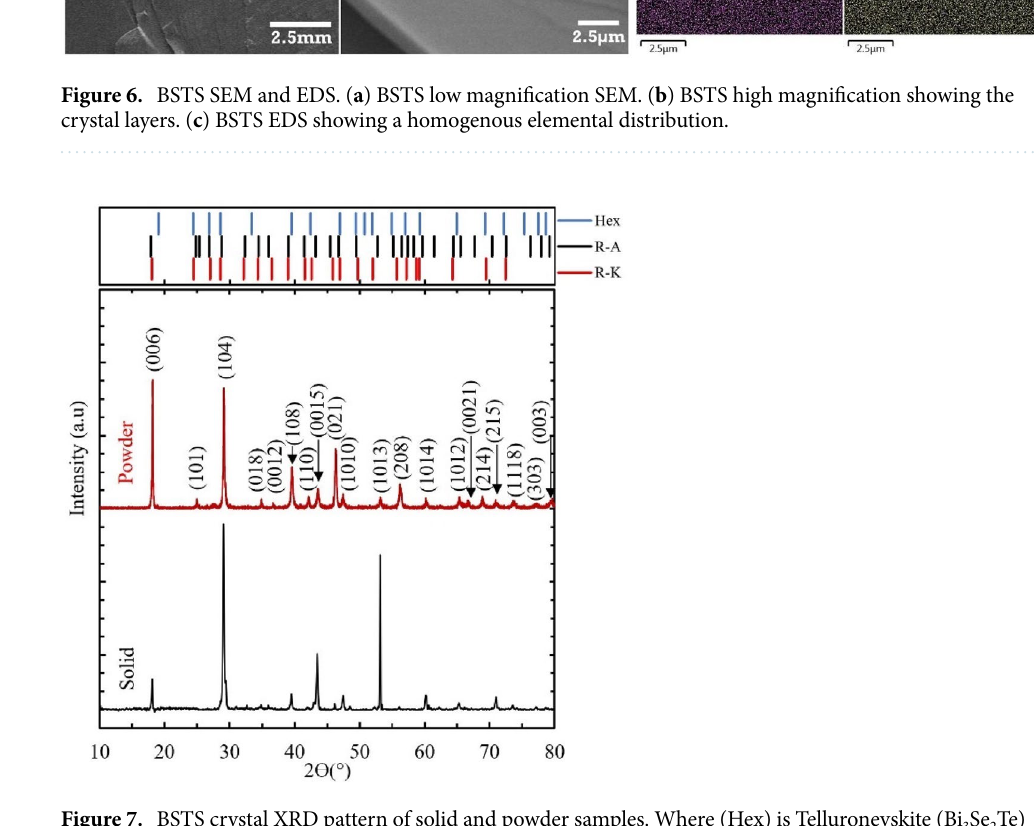
Figure 7. BSTS crystal XRD pattern of solid and powder samples. Where (Hex) is Telluronevskite (Bi 3 Se 2 Te) hexagonal structure, (R–A) is antimony selenium telluride (Sb 2 SeTe 2 ) rhombohedral structure and (R–K) is Kawazuite (Bi 2 Te 2 Se) rhombohedral